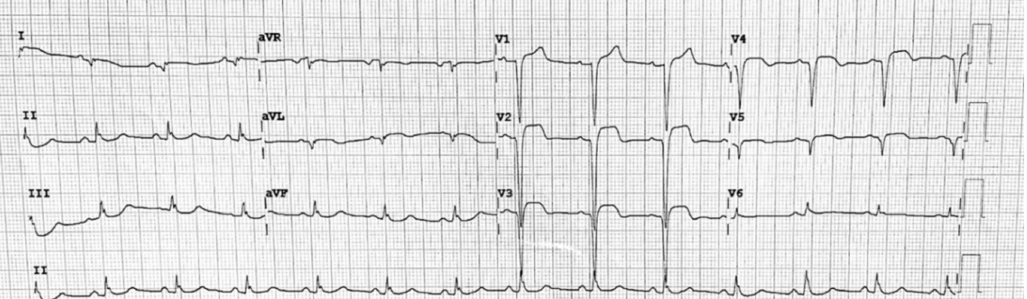
Figure 1. Twelve-lead EKG from a 60 years old patient five days after admission in our referral hospital for antero-lateral ST-segment elevation myocardial infarction (STEMI). Patient underwent primary revascularization of left descending coronary artery. Five days after reperfusion, patient experienced hypotension and new chest pain episode. EKG showed a new ST-segment elevation in the anterior precordial leads. Prompt bedside echocardiography showed an acute mild-to-moderate pericardial tamponade. The origin site of this tamponade was not